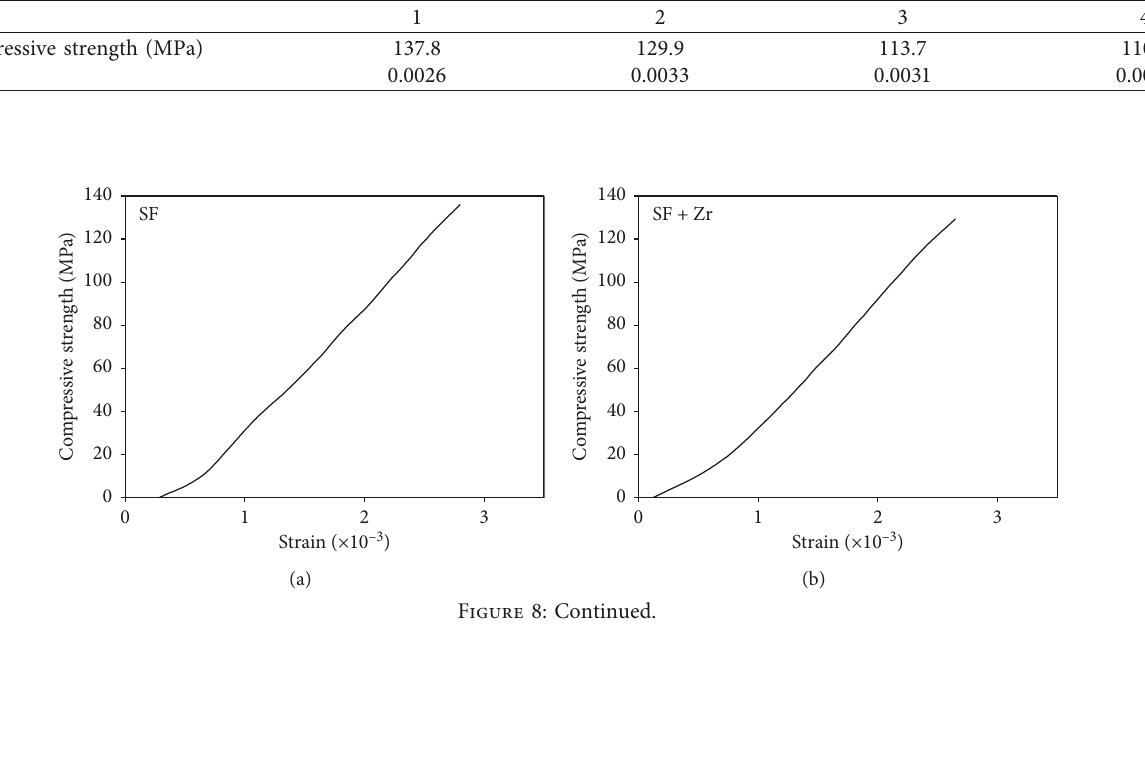
Table 13: Compression test results.